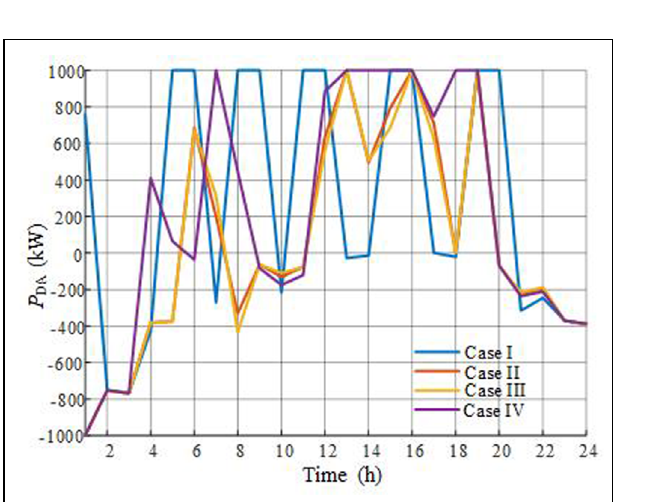
FIGURE 5 | Real-time bidding curve differences in different scenarios between case II and case III.